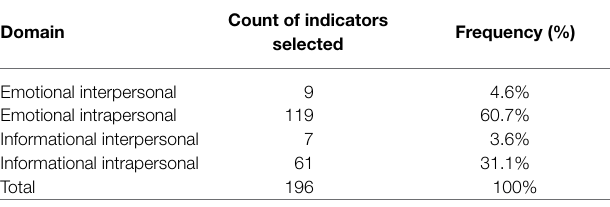
TABLE 3 | Frequency of indicators chosen within each domain.